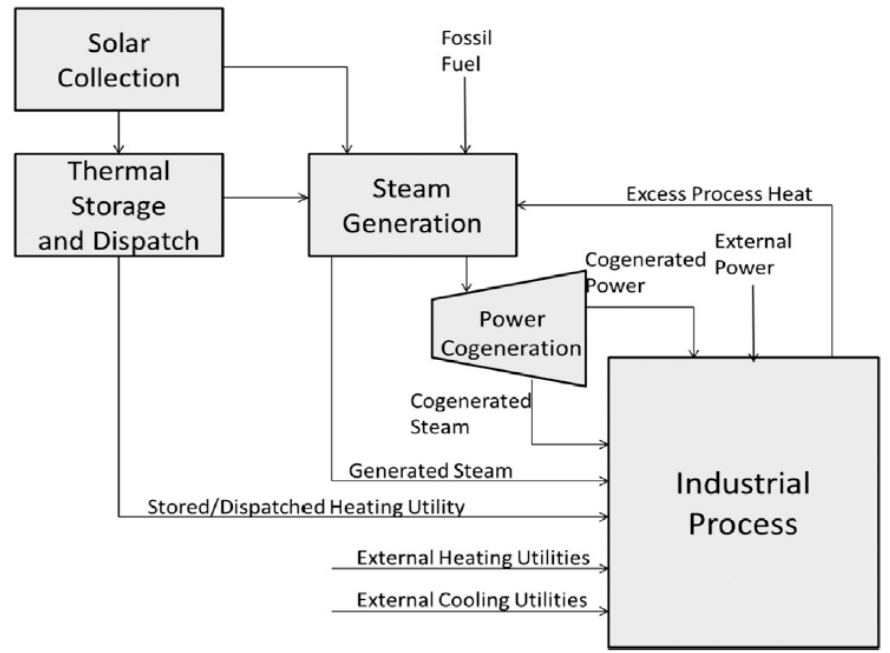
Figure 2. Schematic of the solar fossil-fueled CHP plant combined with a thermal storage and dispatch system [29].